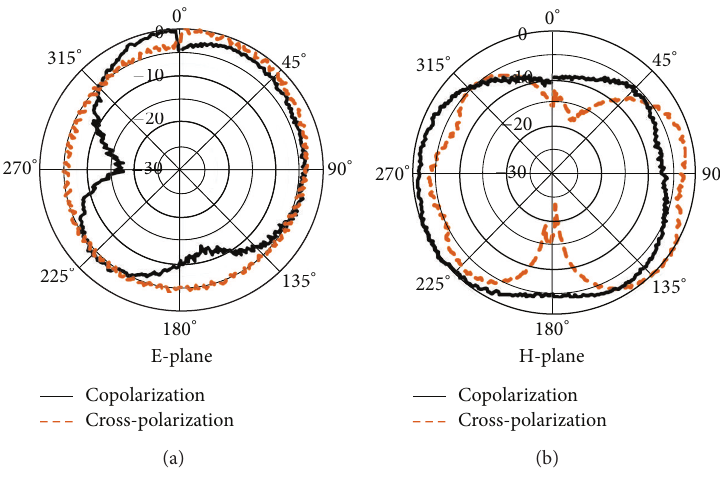
Figure 6: Measured normalized radiation pattern of the proposed